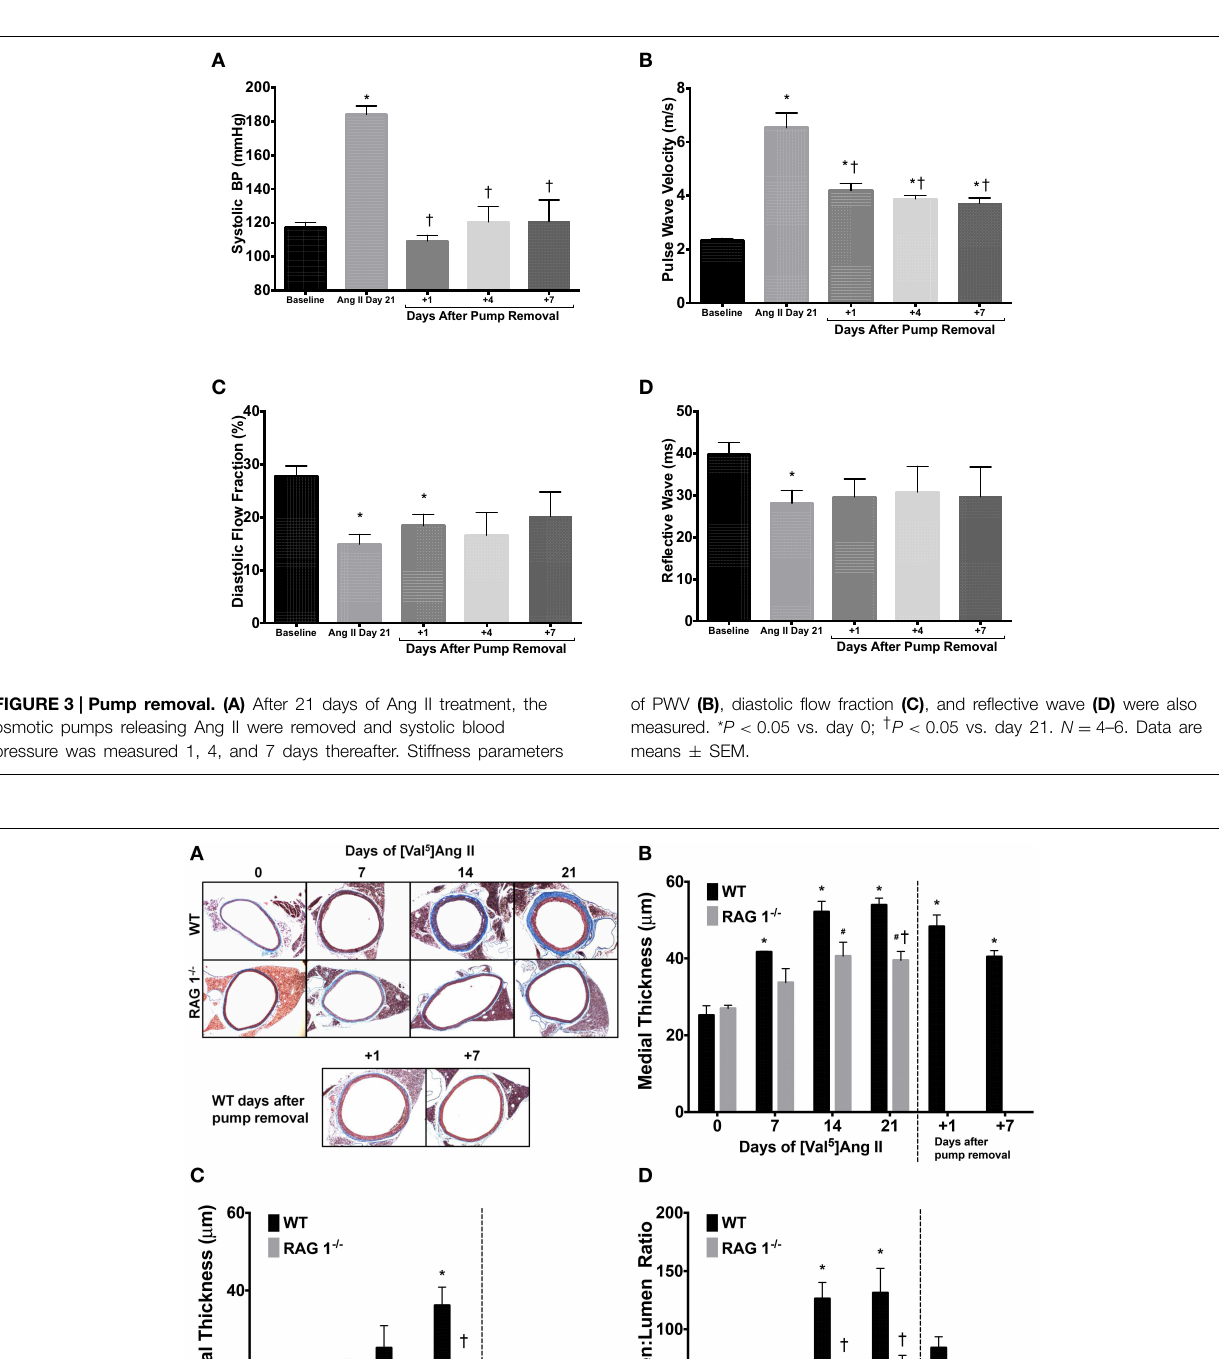
FIGURE 4 | Histomorphometrics of aortic cross-sections. Representative trichrome images show aortic remodeling over the time course of Ang II treatment in WT and RAG 1 − / − mice and after pump removal in WT mice (A) . Medial (B) and adventitial (C) thicknesses were